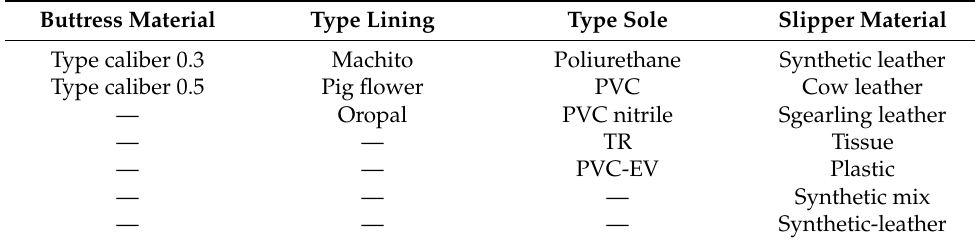
Table 3. Design levels for D(21,2 1 3 1 5 1 7 1